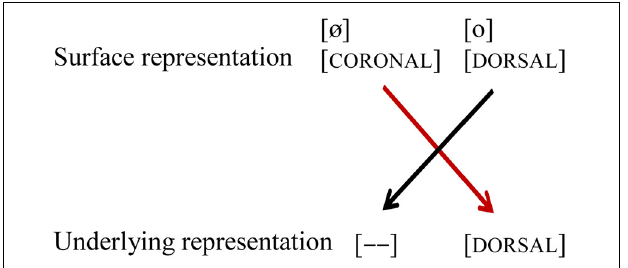
FIGURE 7 | Asymmetrical perception of the vowel pair /o-ø/. Black lines indicate no-mismatch, the red line indicates a mismatch. [– –] indicates